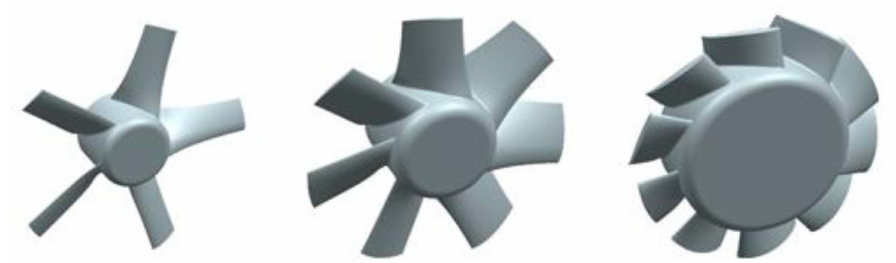
Figure 1. Typical axial impellers with increasing hub-to-tip ratio from left to right (classic blade shape); duct-type casing is not shown.